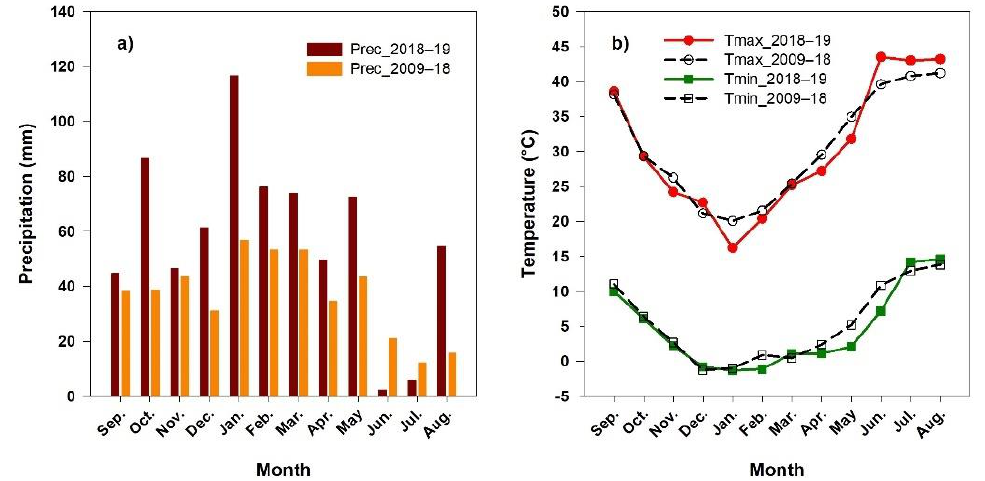
Figure 2. ( a ) Monthly precipitation (Prec), ( b ) minimum air temperature (Tmin), and maximum air temperature (Tmax) during the growing season (2018–2019) and their long-term averages (2009–2018) at experimental